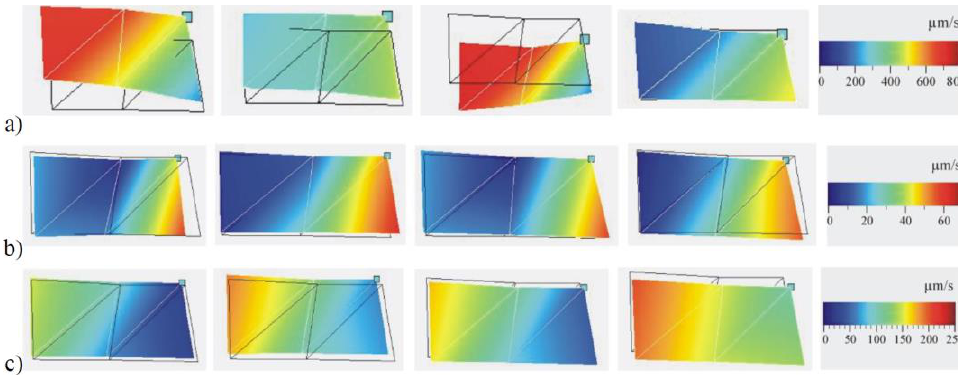
Figure 10. Images of the sample that were re-established with PSV Presentation software corre- sponding to the frequency of 500 Hz ( a ), 1000 Hz ( b ), 1500 Hz ( c ); with a time step of 0.05 ms [48].